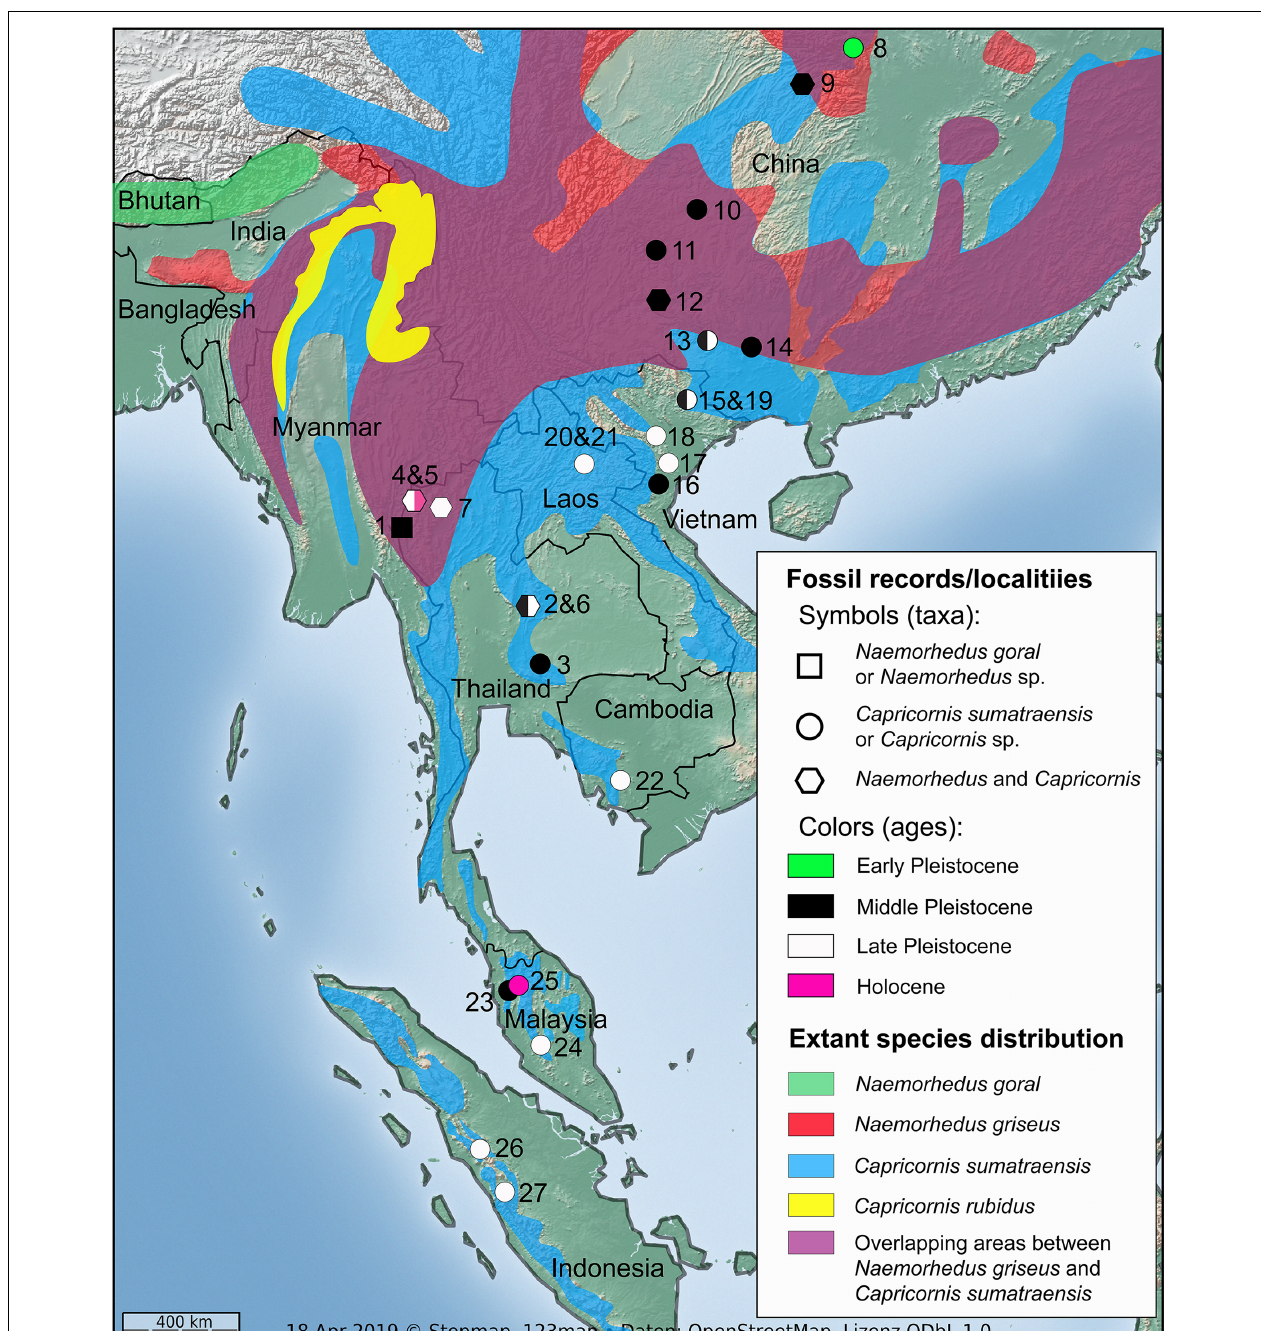
FIGURE 1 | Map of Southeast Asia and South China showing the fossil caprine records from the Early Pleistocene to Holocene sites and the species distribution areas of extant taxa. Numbers of caprine-bearing fossil sites: 1 = Pha Bong (Bocherens et al., 2017), 2 = Tham Wiman Nakin (Tougard, 1998, 2001; Pushkina et al., 2010), 3 = Khok Sung (Suraprasit et al., 2016), 4 = Tham Lod Rockshelter (Wattanapituksakul et al., 2018), 5 = Ban Rai Rockshelter (this study), 6 = Tham Prakai Phet (Filoux et al., 2015), 7 = Cave of the monk (Zeitoun et al., 2010), 8 = Gongwangling (Hu and Qi, 1978; Han and Xu, 1985), 9 = Yenchingkou (Colbert and Hooijer, 1953), 10 = Chihchin (Kahlke, 1961), 11 = Guanyindong (Li and Wen, 1986), 12 = Panxian Dadong (Han and Xu, 1985), 13 = Wuyun (Chen et al., 2002; Wang et al., 2007; Rink et al., 2008), 14 = Wuming (Xue and Zhang, 1991; Rink et al., 2008), 15 = Coc Muoi (Bacon et al., 2018a), 16 = Tham Om (Olsen and Ciochon, 1990), 17 = Lang Trang (Long et al., 1996), 18 = Duoi U’Oi (Bacon et al., 2008a), 19 = Keo Leng (Olsen and Ciochon, 1990), 20 = Tam Hang (Bacon et al., 2011, 2015), 21 = Nam Lot (Bacon et al., 2008b, 2012), 22 = Boh Dambang (Bacon et al., 2018c), 23 = Badak Cave C (Ibrahim et al., 2013), 24 = Batu caves (Ibrahim et al., 2013), 25 = Gua Cha (Groves, 1985), 26 = Lida Ajer (Hooijer, 1958; de Vos, 1983), and 27 = Sibrambang (Hooijer, 1958; de Vos, 1983). For this study, the isotopic samples were collected from five localities (number 1–5) in Thailand.